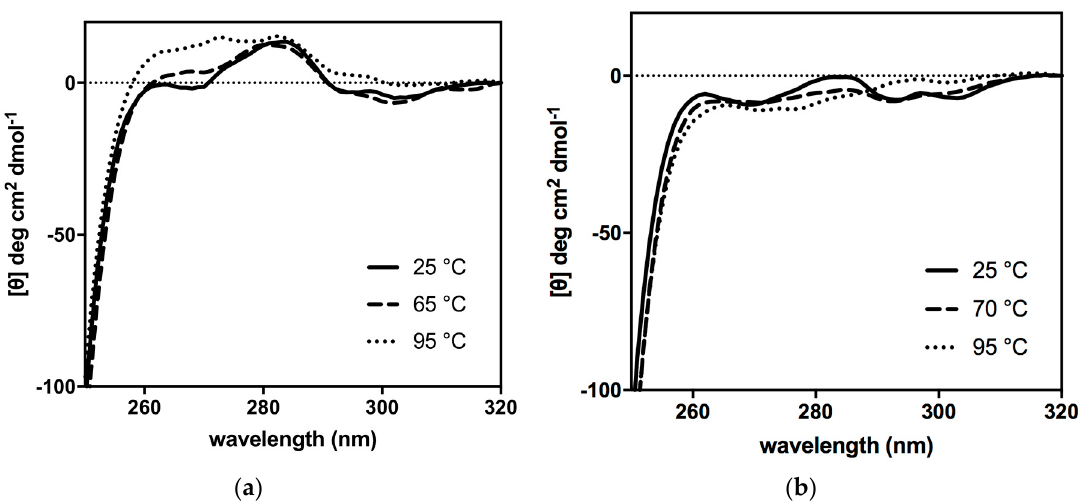
Figure 9. Near-UV CD spectra of ( a ) 3Mut and ( b ) 4Mut. The CD spectra were obtained at 25, 65 and 95 °C for 3Mut, and 25, 70 and 95 °C for 4Mut.